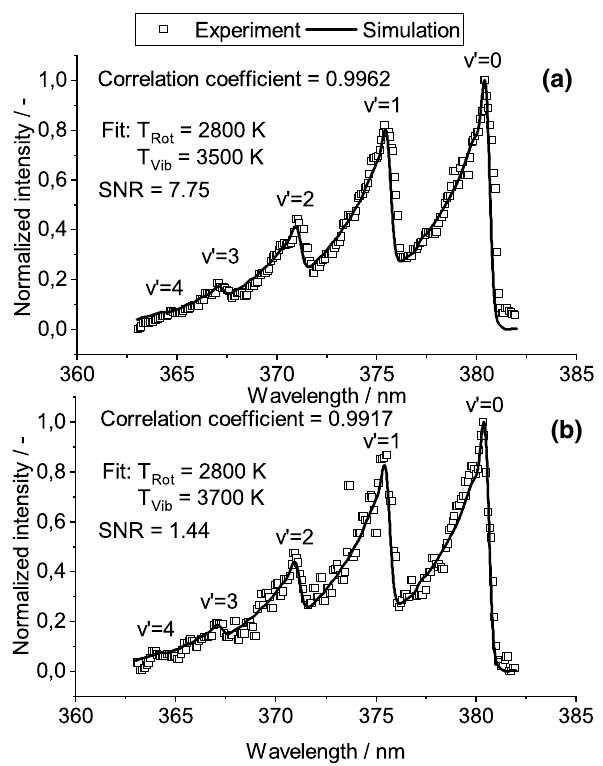
Fig. 5 Two spectra with different signal-to-noise ratios (SNR) and the corresponding fit. a Fit of a spectrum in the negative glow of a glow discharge with high signal-to-noise ratio of 7.75. b Fit of a spectrum in the positive column of a glow discharge with a low signal-to-noise ratio of 1.44. The given signal-to-noise ratio is calcu- lated from the quotient of the signal intensity and the background noise